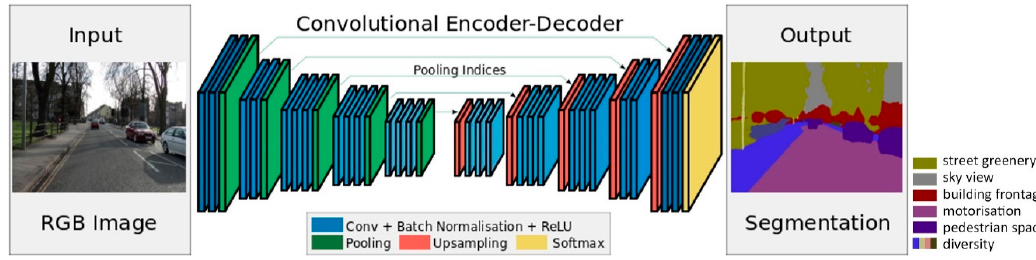
Figure 5. Distribution of sampling points for capturing street-view images (SVIs) of Yangpu District.